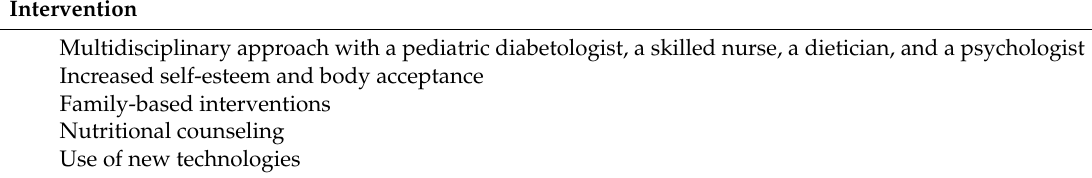
Table 3. Main useful interventions for prevention and treatment of eating disorders (EDs) and disordered eating symptoms (DES) in adolescents with type 1 diabetes